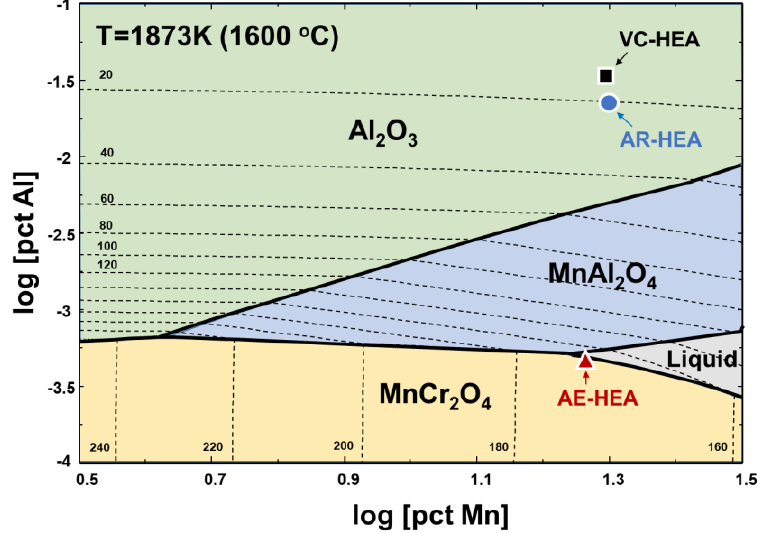
Figure 4. Phase stability diagram of MnCr 2 O 4 , MnAl 2 O 4 , and Al 2 O 3 at 1873 K. Black, blue, and red dots indicate VC-HEA, AR-HEA, and AE-HEA, respectively.